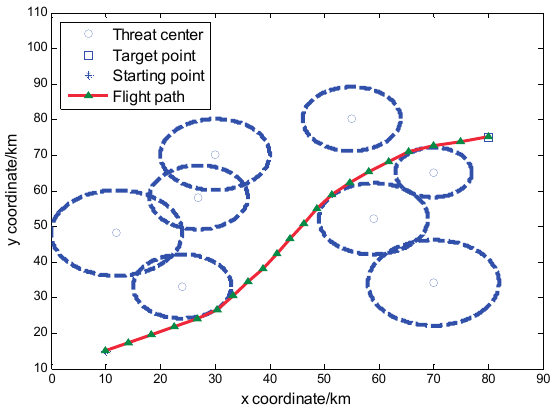
Figure 14. Result of the second instance for Maxgen = 100.